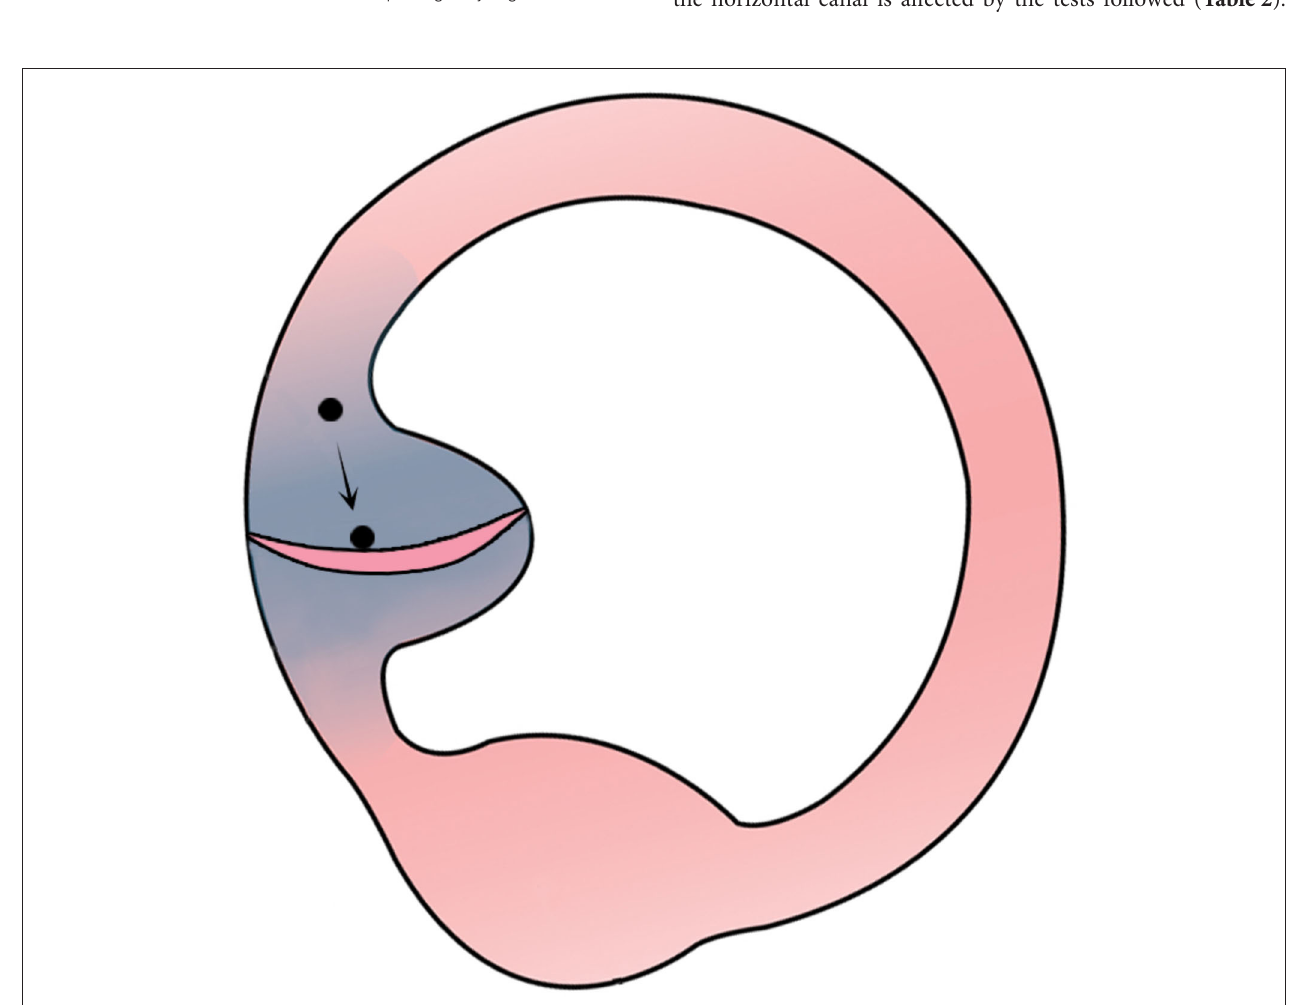
FIGURE 6 | Debris moving from the ampullary arm to exert force on the cupula and produce a cupulolithiasis-like effect.